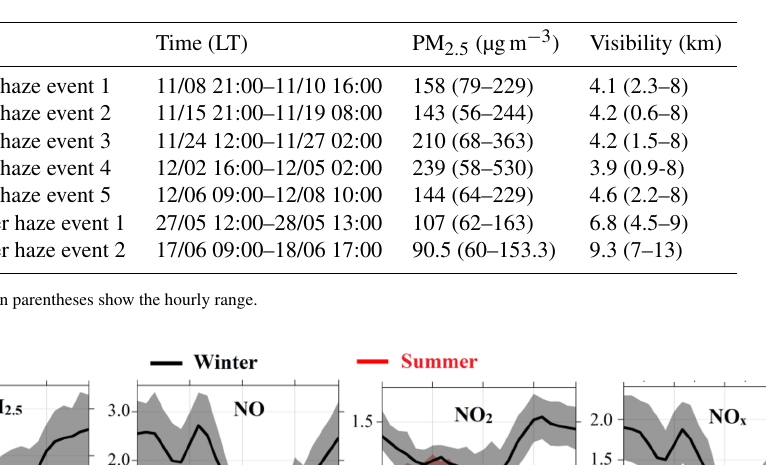
Table 5. Haze periods during the summer and winter campaign periods.